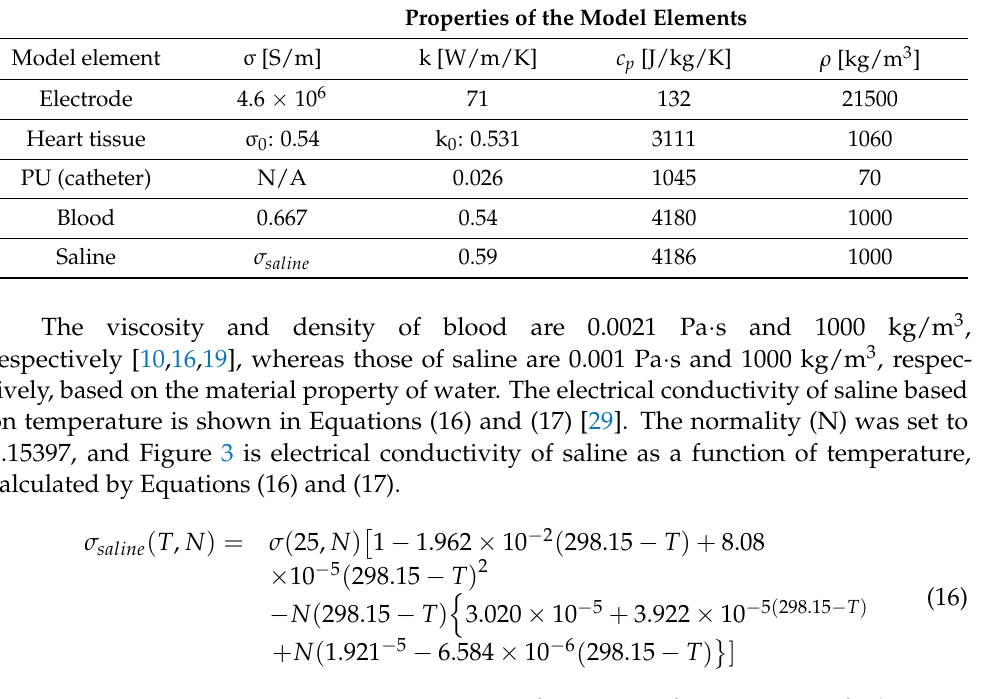
Table 1. Material properties of the model elements.